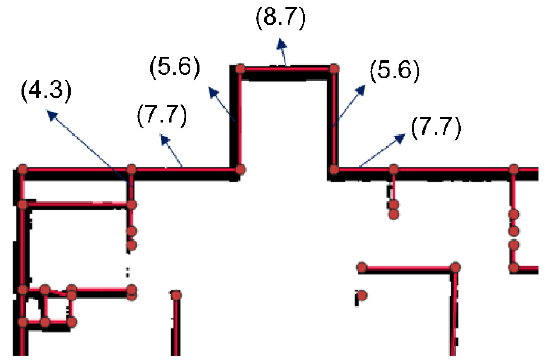
Figure 10. Number of pixels (estimated, ground truth).